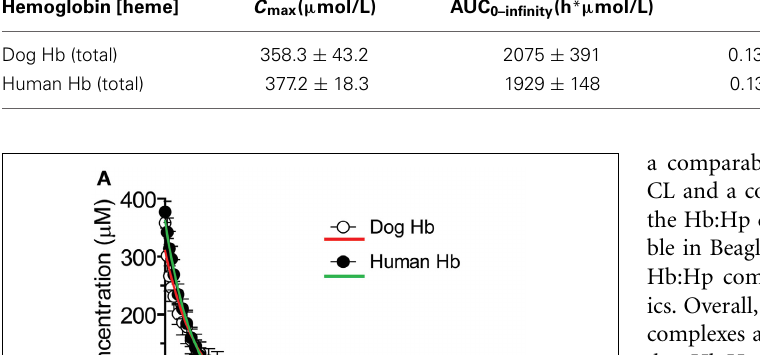
Table 1 | Pharmacokinetic parameters of dog and human hemoglobin (Hb) (mean ± SEM) in Beagles. Hemoglobin [heme]